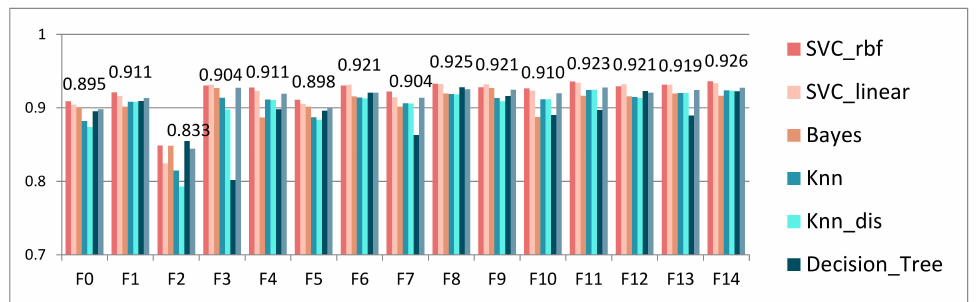
Figure 4. The F1 score of combination of e-learning behavior